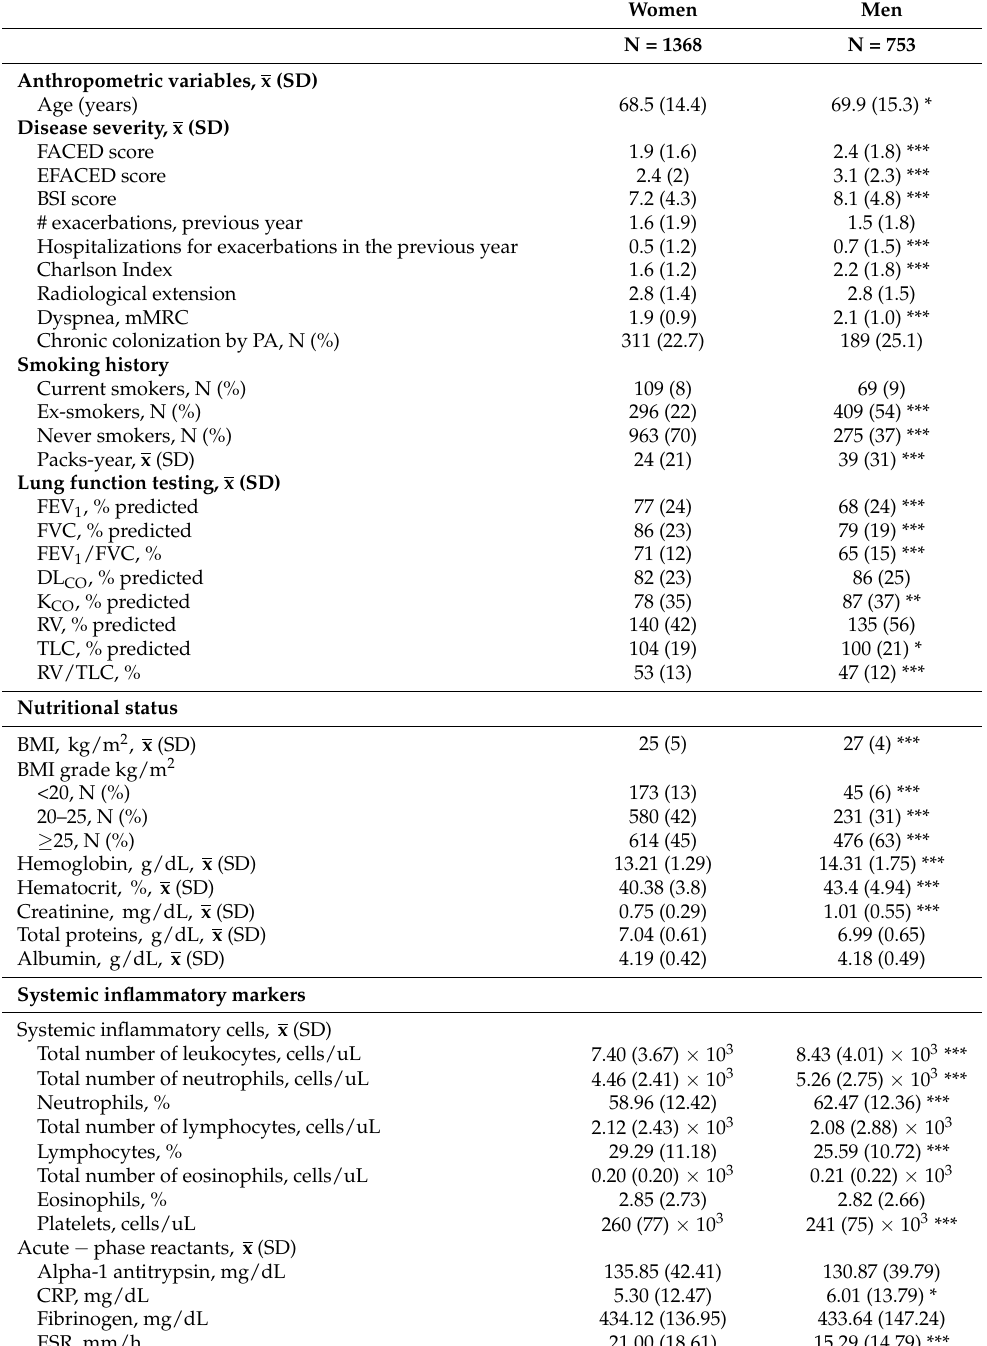
Table 1. Clinical parameters and nutritional and inflammatory status of all the study patients: females and